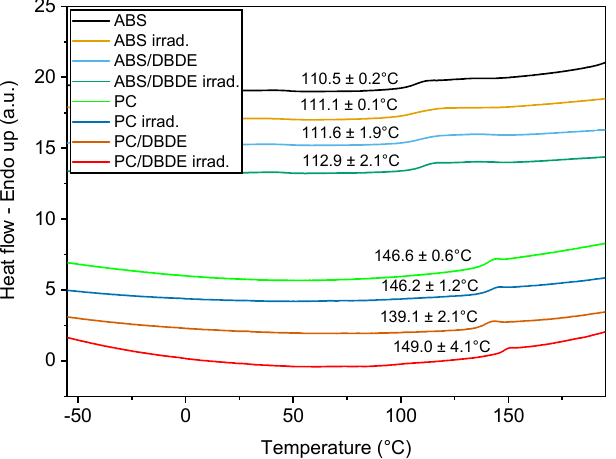
Figure 7. DSC thermograms of virgin and irradiated ABS, PC, 90 wt-% ABS/10 wt-% DBDE, and 90 wt-% PC/10 wt-% DBDE samples. The temperatures given in this figure correspond to the glass transition.